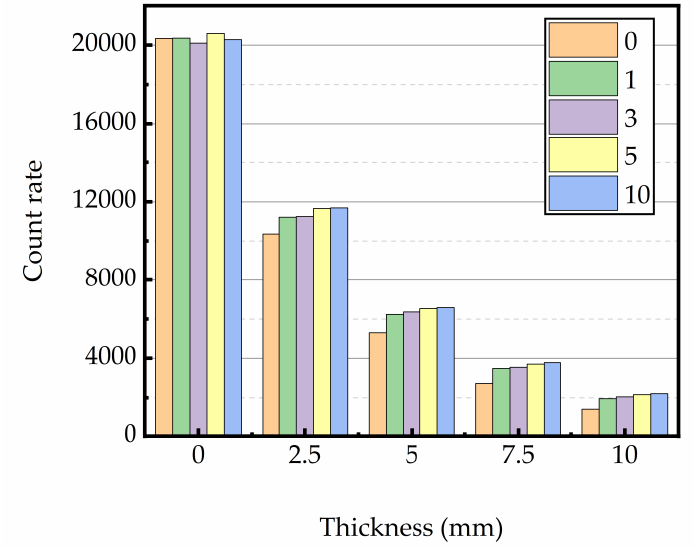
Figure 14. Relationship between thickness and counts at 400 °C.